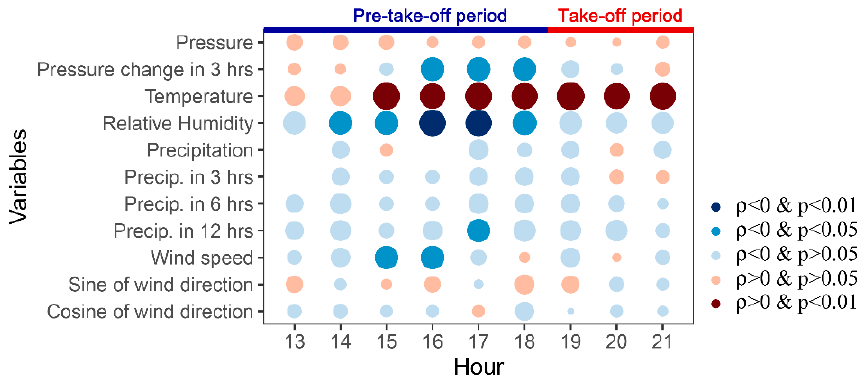
Figure 2. Spearman’s correlation coefficients ( ρ ) between the daily numbers of O. asiaticus taking off and several meteorological factors in the afternoon (pre-take-off) and evening.